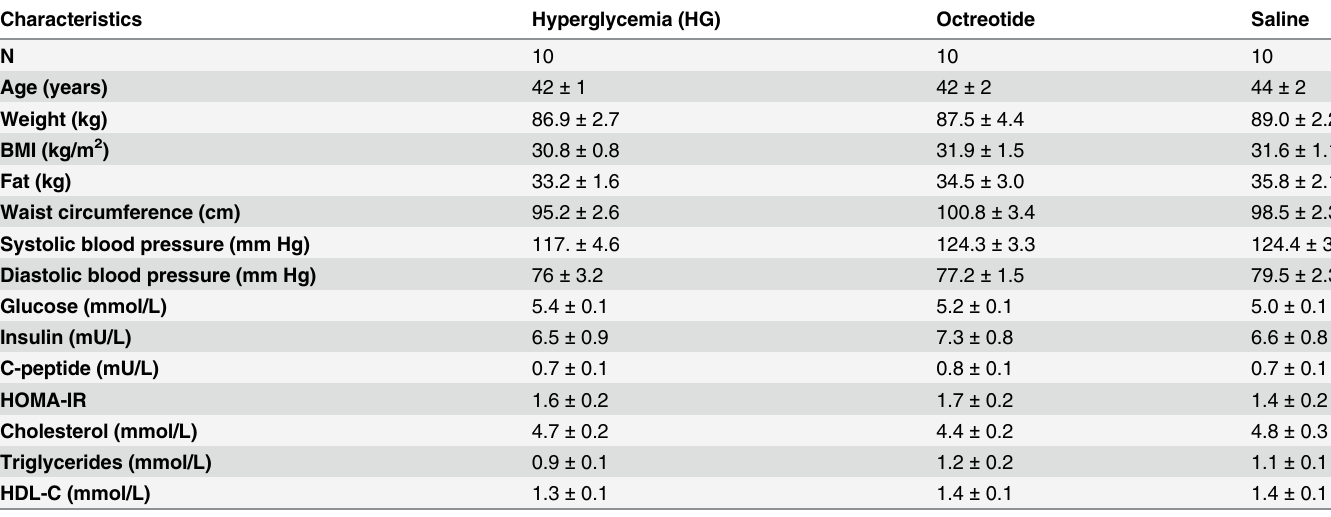
Table 1. Characteristics of obese subjects in experimental